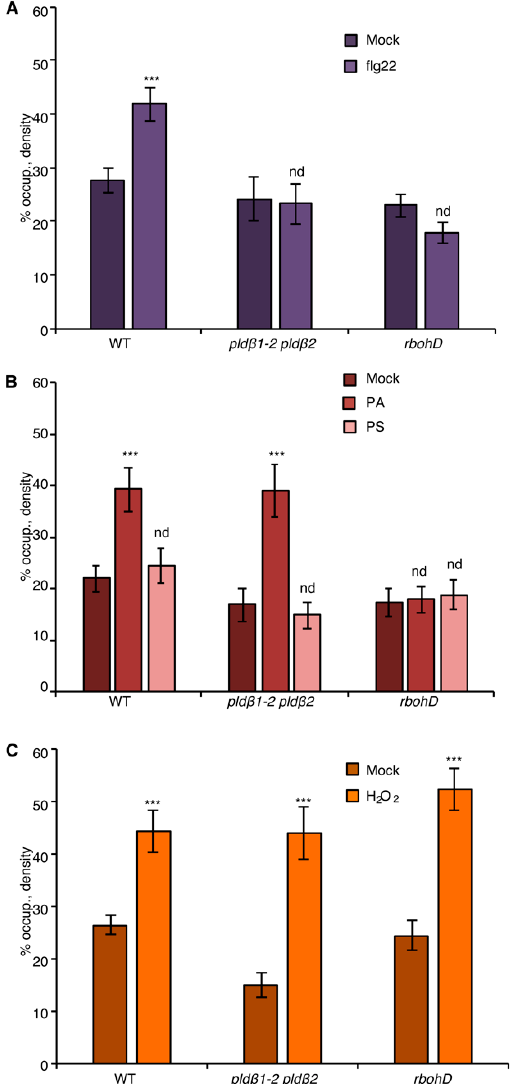
Figure 3. The NADPH oxidase, RBOHD, is necessary for PA-mediated actin remodeling. ( A ) Actin filament abundance in epidermal cells of WT, pld β 1-2 pld β 2 , and rbohD cotyledons after mock or flg22 treatment. Compared to mock treatment, the density of actin filaments elicited by flg22 increased significantly in WT, but not in pld β 1-2 pld β 2 or rbohD mutants. ( B ) Actin filament abundance in WT, pld β 1-2 pld β 2 , and rbohD seedlings after treatment with 50 µM exogenous phosphatidic acid (PA) for 20 min. In WT, compared to mock, PA stimulated an increase in actin filament density. Similarly, the density of actin filaments increased significantly in pld β 1-2 pld β 2 mutant after chemical complementation with PA. By contrast, there was no significant change in actin filament density in the rbohD mutant after treatment. Phosphatidylserine (PS; 50 µM) was used as a negative control for the same experiments. ( C ) Actin filament density in WT, pld β 1-2 pld β 2 , and rbohD seedlings after 1 µM H 2 O 2 treatment for 20 min. In WT, compared to mock, H 2 O 2 induced an increase in actin filament density. Similar increases in actin filament density were also measured in pld β 1-2 pld β 2 and rbohD mutants when treated with exogenous H 2 O 2 . Values given represent mean ± SE; n = 50 images from 10 cotyledons per genotype and treatment; *** p < 0.001; nd, no difference, Student t-test. To address whether there is crosstalk between PA and ROS signaling, chemical com- plementation experiments were conducted by applying exogenous PA to wild-type or rbohD cotyledons, and actin remodeling was evaluated. When compared to mock and neg- ative control (phosphatidylserine or PS) treatment, PA-stimulated cortical actin accumu- lation was eliminated in rbohD (Figure 3B) and demonstrated that RBOHD is required for